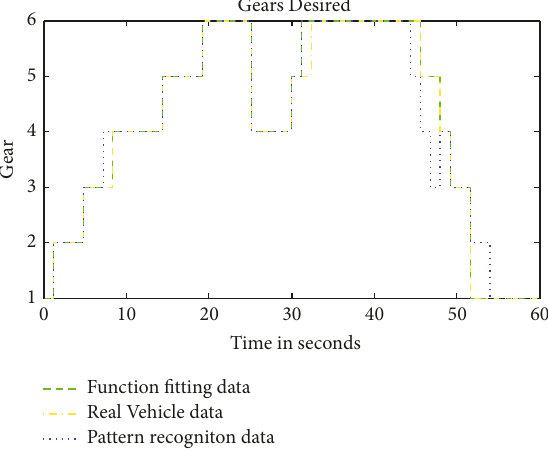
Figure 23: Gear timing of road test 3.